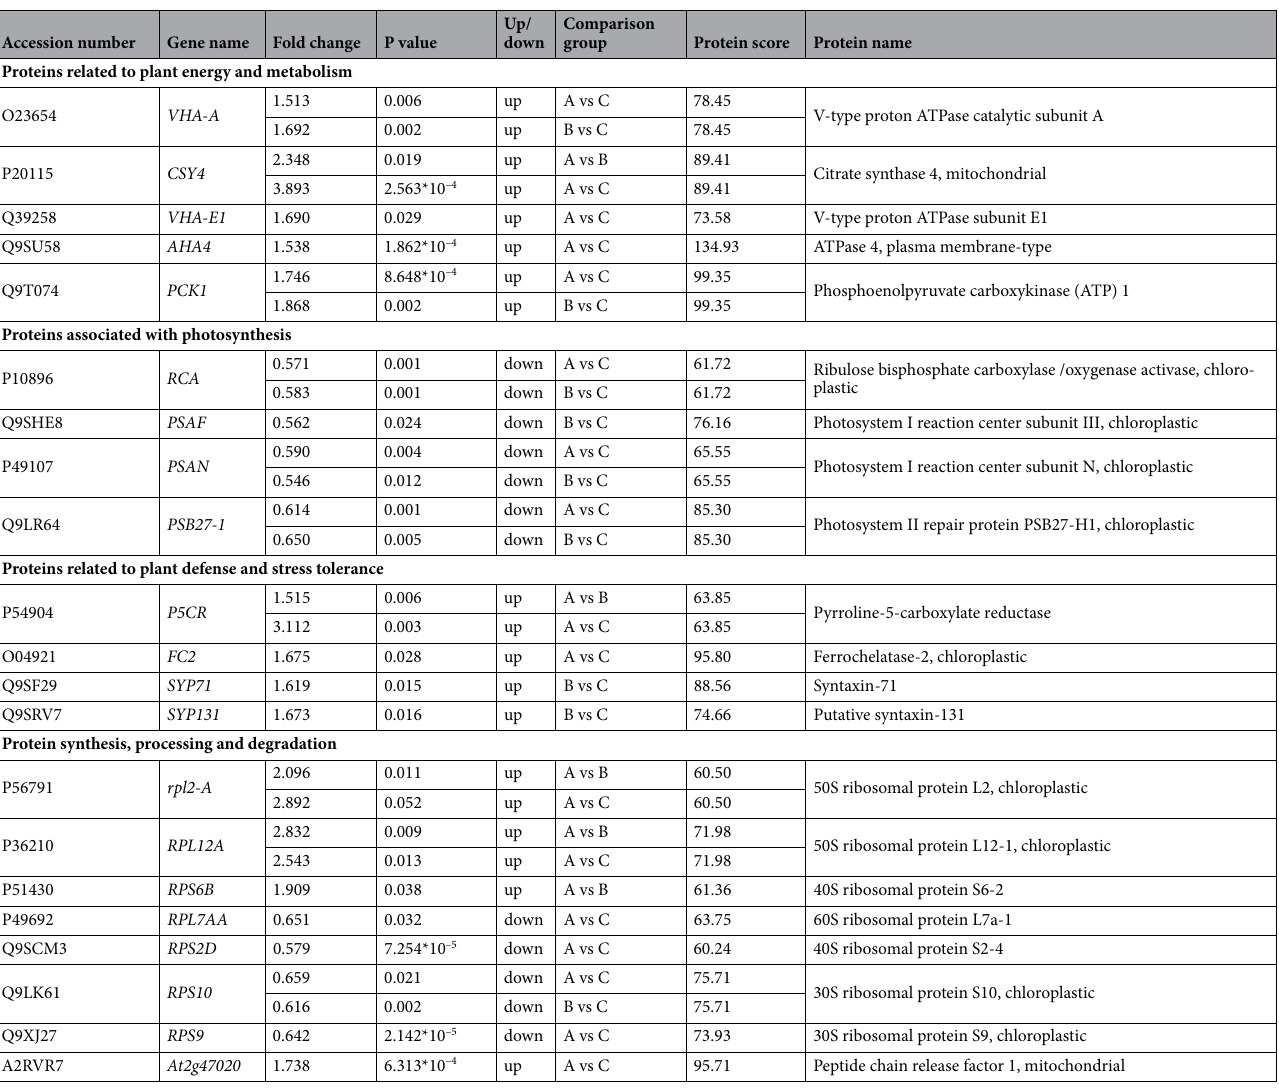
Table 2. The key DEPs significantly expressed under salt